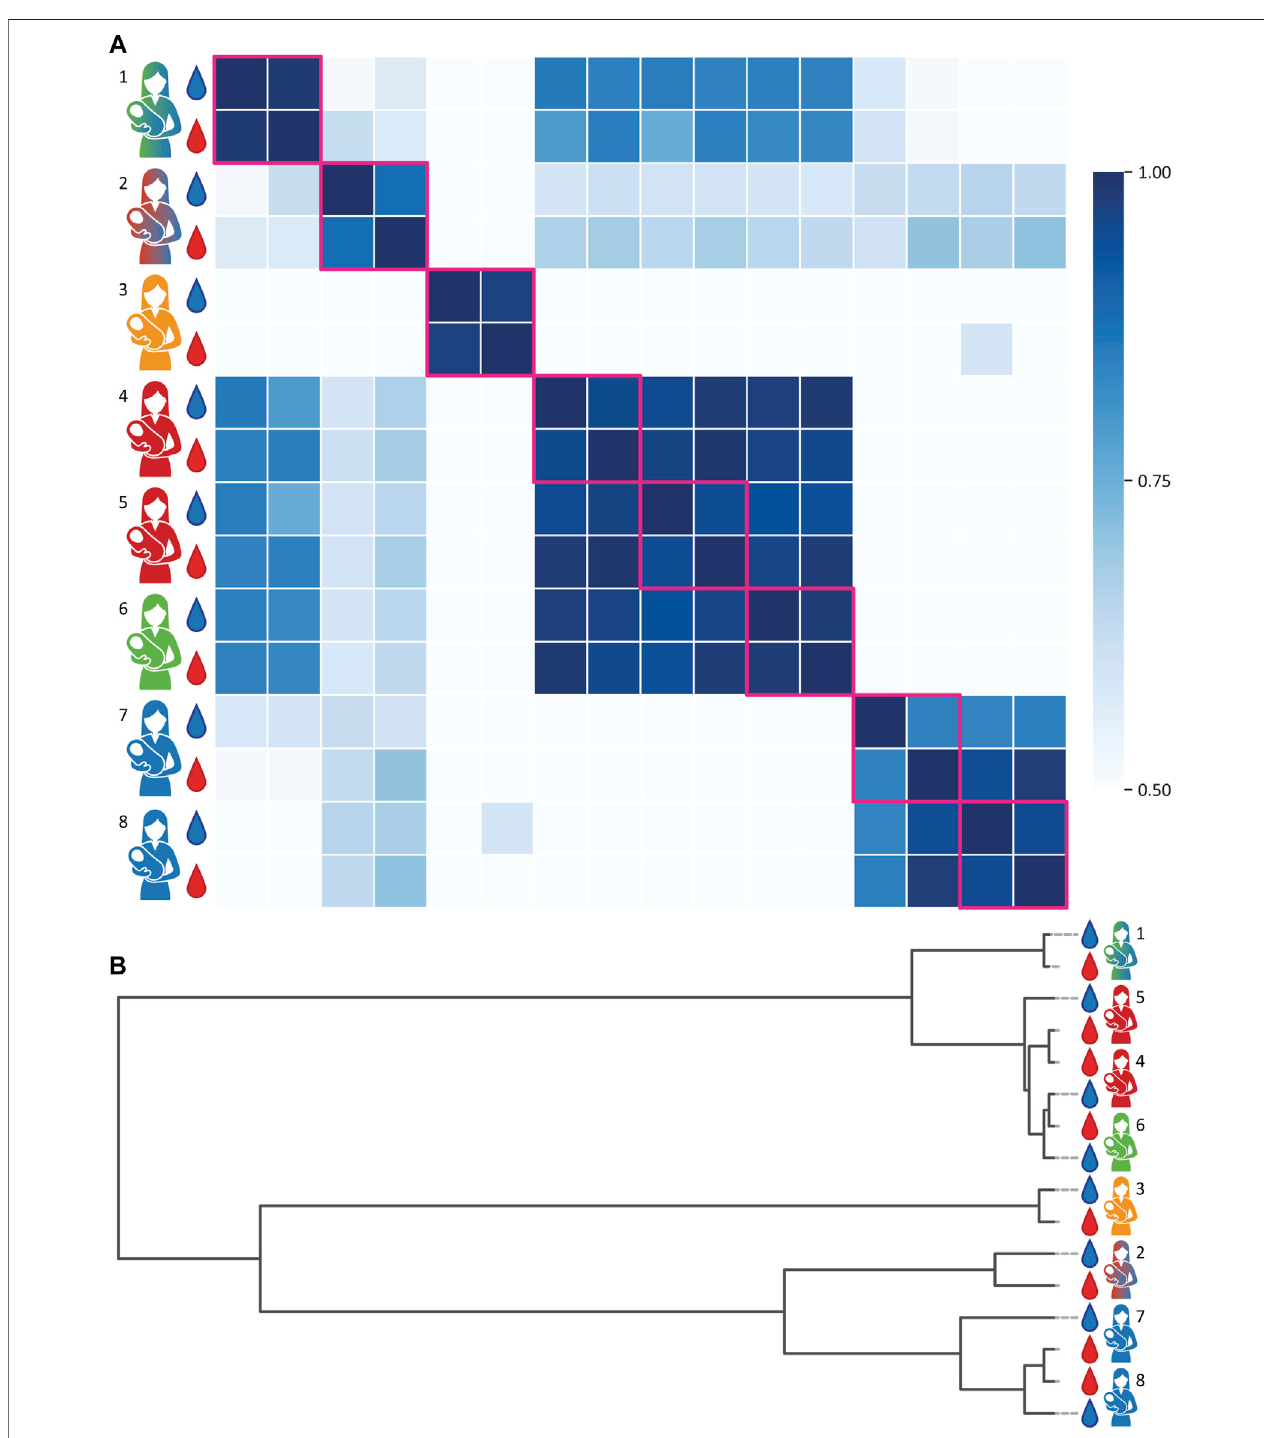
FIGURE3| Proteoform pro fi lecorrelationsofA1ATobtainedfrom paired milk andserumsamplesofeight individual donors. Donorsand samplesarecolor-coded as in Figure 1 , milk and serum are depicted as blue and red droplets, respectively. (A) A correlation matrix of all samples. Within the same donor the A1AT proteoform pro fi lesofserumandmilkshowaveryhighcorrelation.Donorsofthesamegenotype,orheterozygousgenotypeswithcommonalleles,tendtohaveahigherinter-donor correlation. Milk and serum of donors 2 and 7 have a slightly lower intra-donor relation, due the presence of an unknown protein contaminant in the milk sample. When disregarding the 51,201.00 Da contaminant in the milk sample of donor 2, the correlation number (r) increases from 0.88 to 0.98. All R-values can be found in the Supplementary Table S3 . (B) clustering dendrogram depicting the correlation, whereby the vertical axis represents the proteoform pro fi les of each donor and the horizontal scale represents the (dis)similarity between the